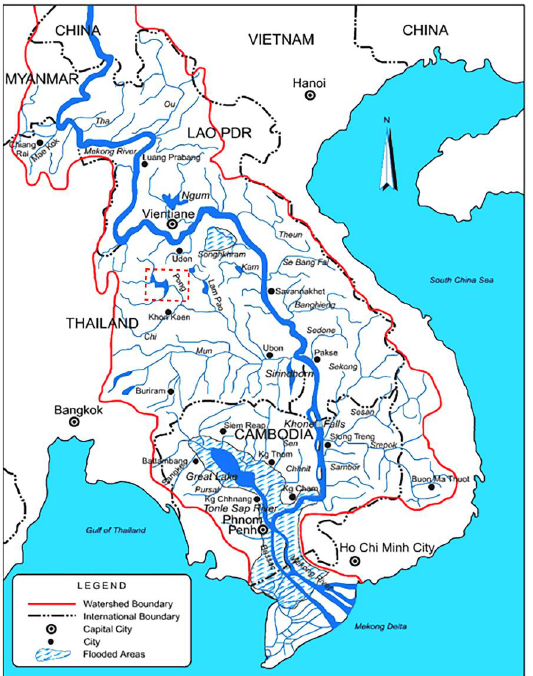
Figure 1. Map of the Lower Mekong River hydrographic basin with the study site along Pong River (indicated by a red dashed-line square) in Northeastern Thailand, Southeast Asia (modified from van Zalinge et al. [18]).